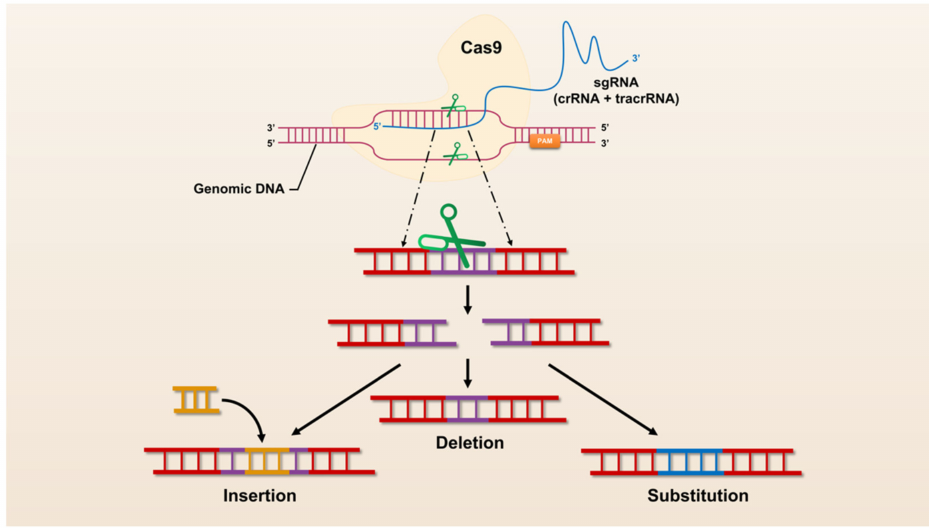
Figure 1. The mechanism of CRISPR/Cas9 mediated genome engineering.